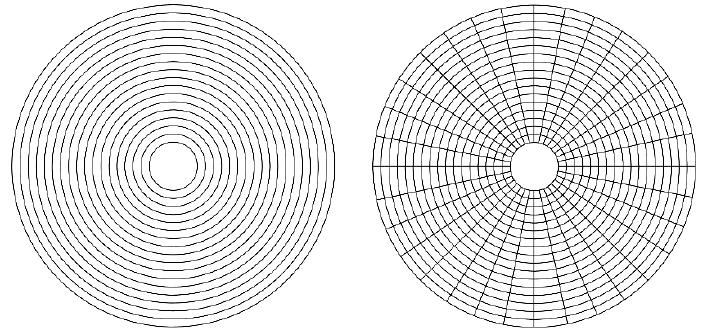
Figure 2. Top views of the R0 pad and R32 pad.